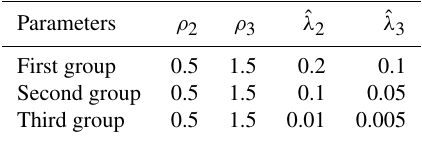
Table 3. Value of each parameter (test parameters ρ 2 and ρ 3